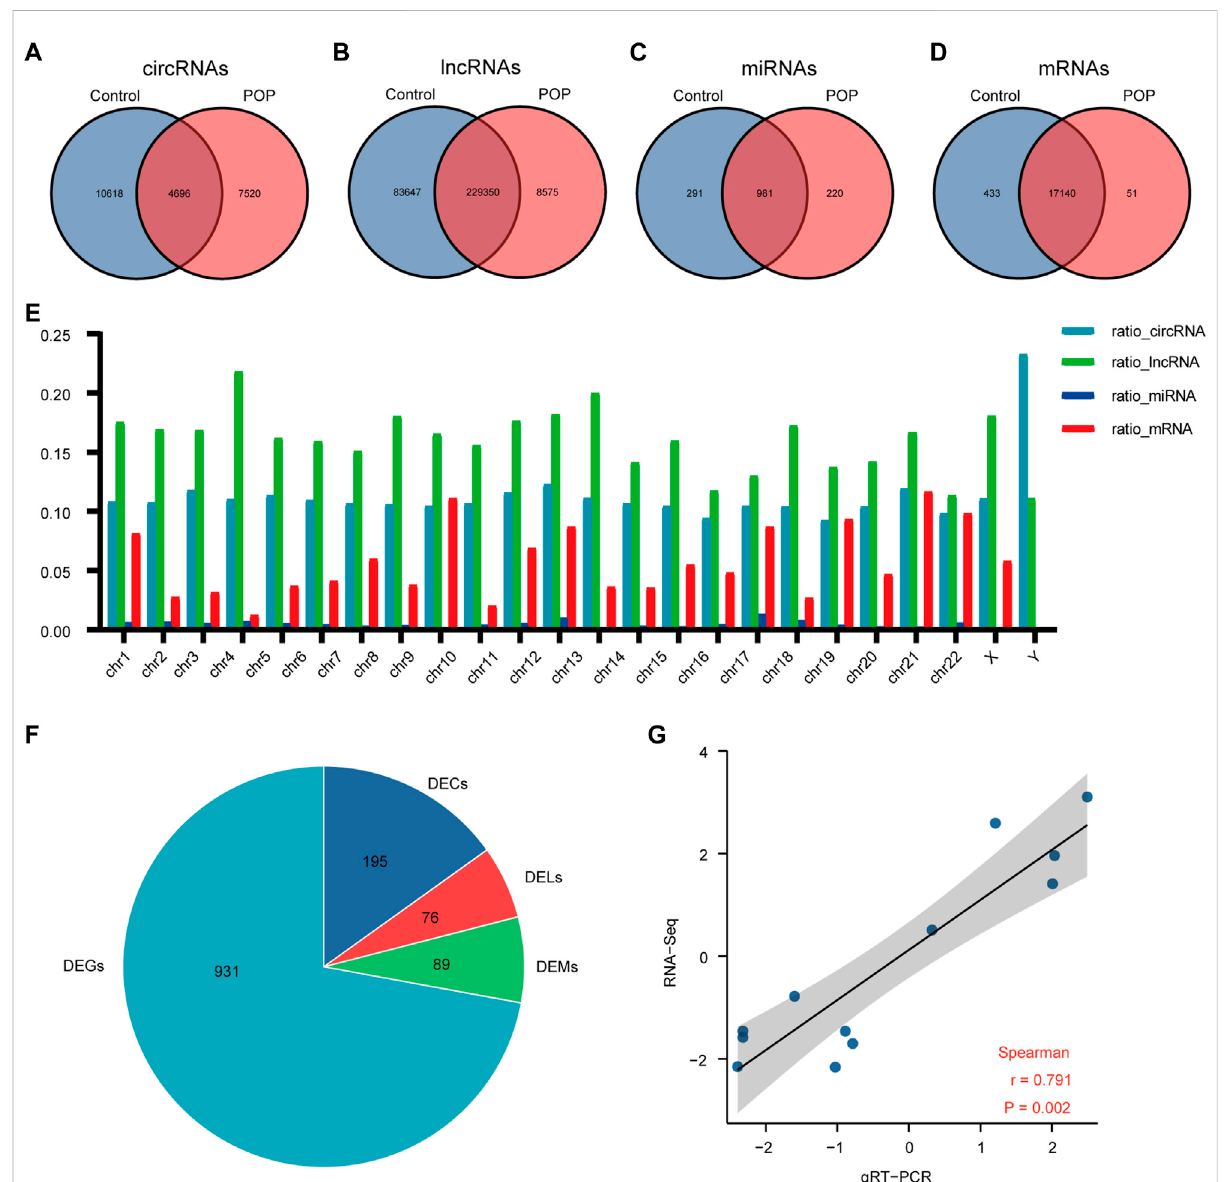
FIGURE 3 Whole transcriptomeRNA sequencing results comparing thePOP andcontrol groups. (A – D) Venndiagrams depicting thepro fi les ofcircRNAs, lncRNAs, miRNAs, and mRNAs. (E) RNAexpressionratio ina chromosome (number ofRNAs inarelated chromosome divided by thetotal number of RNAs). (F) Differentially expressedcircRNAs, lncRNAs, miRNAs andmRNAsbetweenthePOP andcontrol groups. (G) qRT ‒ PCR validation oftheRNA sequencing results using 3 DECs, 3 DELs, 3 DEMs, and 3 DEGs chosen at random. The log2-fold change from the q-RT ‒ PCR analysis is plotted on the X-axis, and the log2-fold change from the RNA sequencing analysis is plotted on the Y-axis. POP, pelvic organ prolapse; DECs, differentially expressed circRNAs; DELs, differentially expressed lncRNAs; DEMs, differentially expressed miRNAs; DEGs, differentially expressed